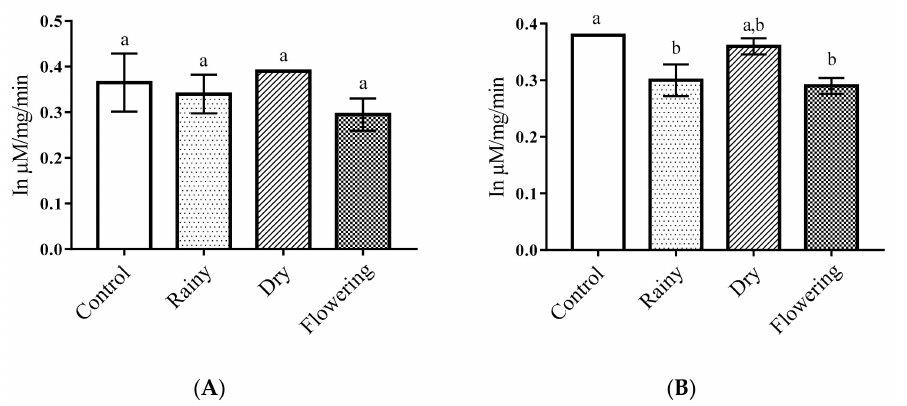
Figure 3. Biochemical changes in alkaline phosphatases of Ae . aegypti and Ae . albopictus larvae. Changes in alkaline phosphatases levels between Ae . aegypti ( A ) and Ae . albopictus ( B ) larvae treated and not treated with the essential oils of Lippia grata Schauer. Different lowercase letters in the bar denote significant difference ( p < 0.05). Bars represent standard deviations ( n = 3). Values estimated by one-way ANOVA followed by the Tukey test. Control, untreated larvae.